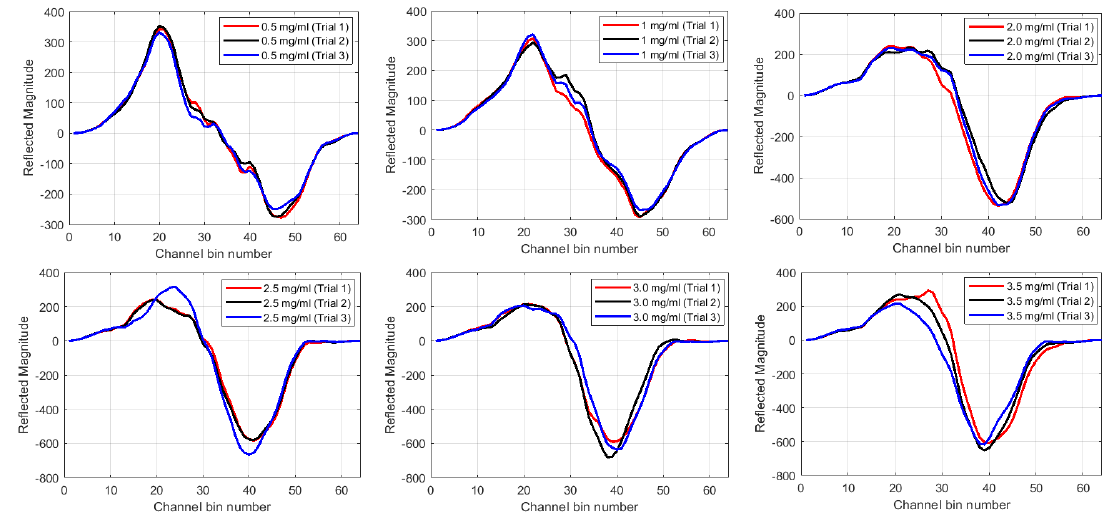
Figure 6. Raw data collected via radar channel 1 for glucose concentrations 0.5–3.5 mg / mL. Each subfigure shows the three measurement trials for each blood glucose concentration sample.